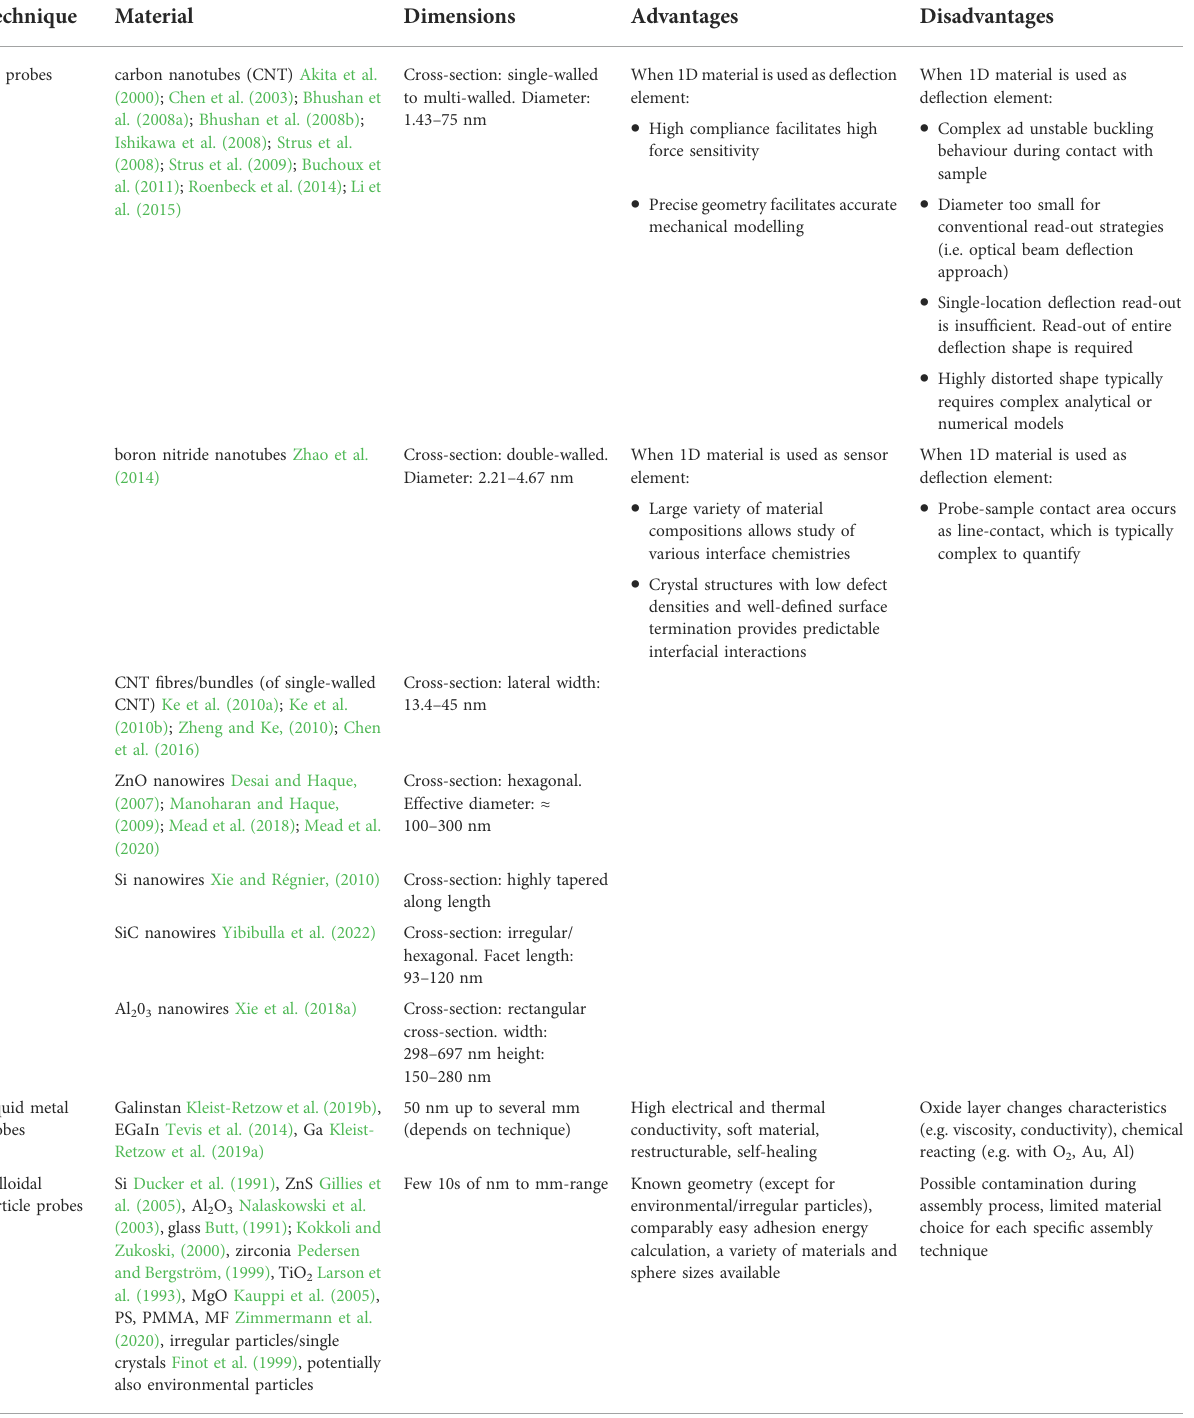
TABLE 2 Summary of characteristics of the bottom up fabricated contact probe designs discussed in this